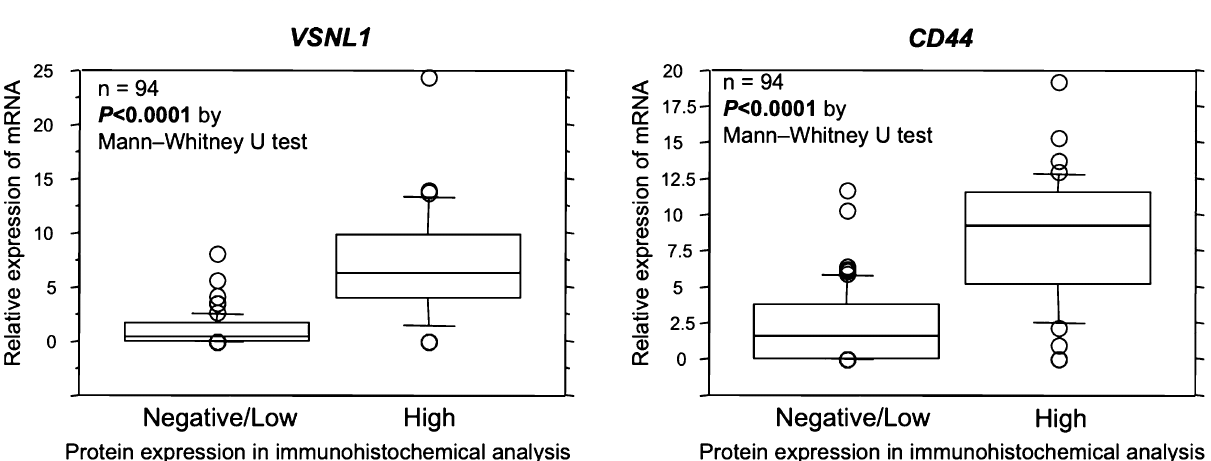
Figure 4. Relationship between mRNA expression levels and protein expression levels of VSNL1 and CD44. The protein expression levels of VSNL1 and CD44 based on immunohistochemistry (IHC) analysis were divided into low and high expression groups. There was a significant difference in the mRNA expression levels of VSNL1 and CD44 between the low and high protein expression groups of both VSNL1 and CD44 based on IHC analysis